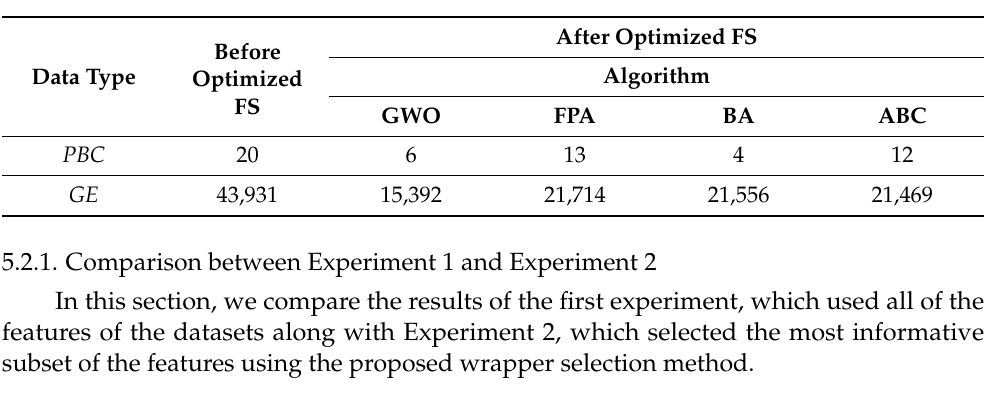
Table 7. Final optimal features.